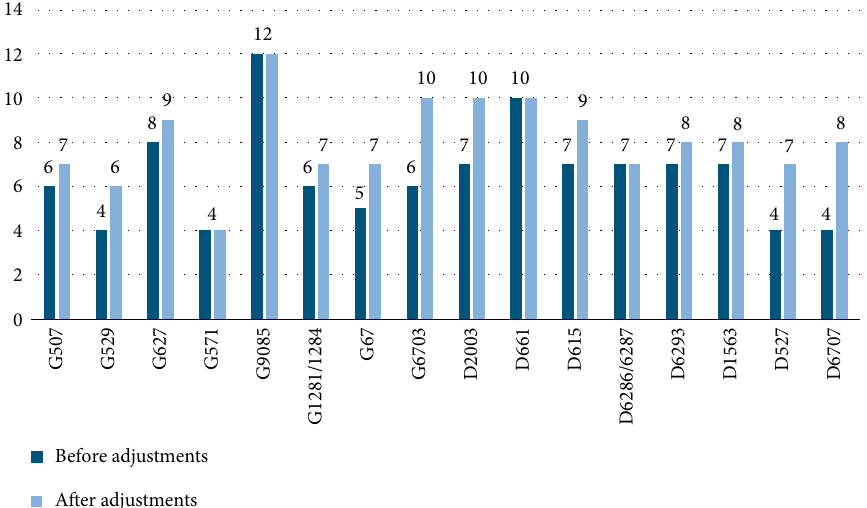
Figure 5: Number of synchronizations for each train.